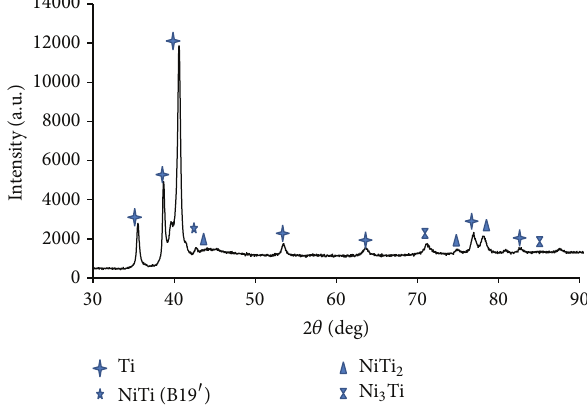
Figure 5: XRD patterns of Ti55Ni45